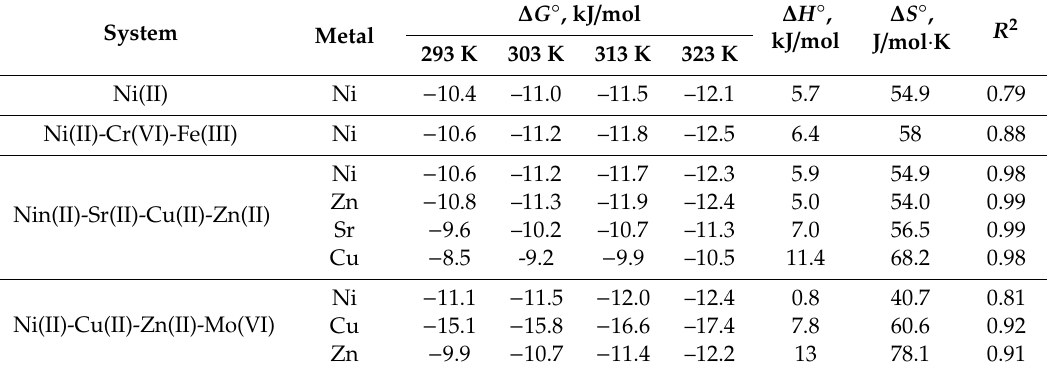
Table 6. Thermodynamic parameters for metal sorption on hybrid